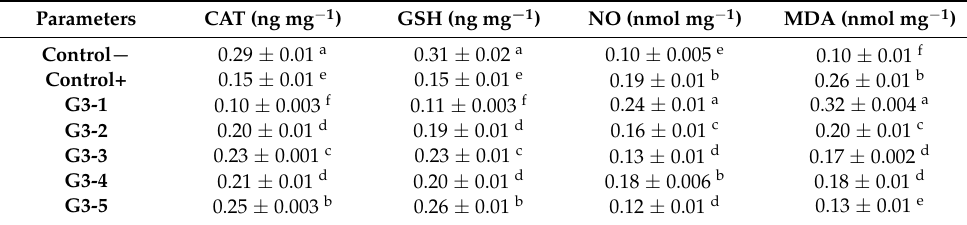
Table 9. Effect of wheat and barley grasses on changes in malondialdehyde, nitric oxide, and some antioxidants levels in the liver homogenate in rats exposed to toxic metals (mean ± SD).